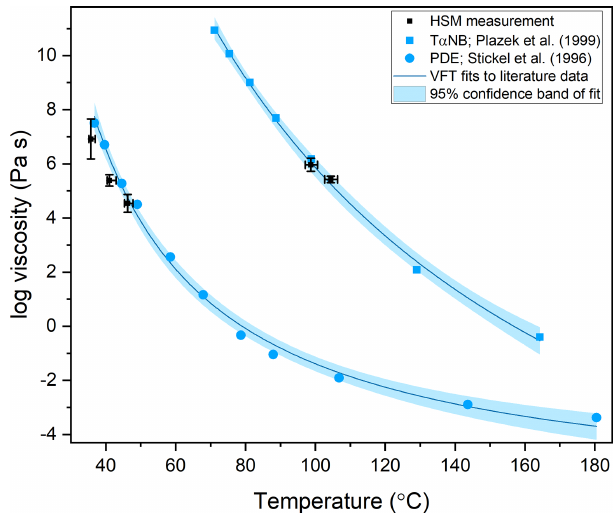
Figure 7. The viscosity of T α NB and PDE as a function of tem- perature. The blue squares are measurements of T α NB from Plazek et al. (1999), and the blue circles are measurements of PDE from Stickel et al. (1996). The blue trend lines are a Vogel–Fulcher– Tammann (VFT) fit to the literature data sets, with the light blue area corresponding to the 95% confidence band of the fits. The black data points are the midpoint of the upper and lower limits measured with the hot-stage microscopy (HSM) technique. The y - error bars correspond to the calculated upper and lower limits of viscosity from at least two separate experiments. The temperature uncertainty ( x error) is a propagation of the uncertainty in the tem- perature control stage calibration and the largest temperature oscil- lation during the experiment. Note that for PDE, the x -error bars are asymmetric because the largest temperature oscillation was always toward hotter